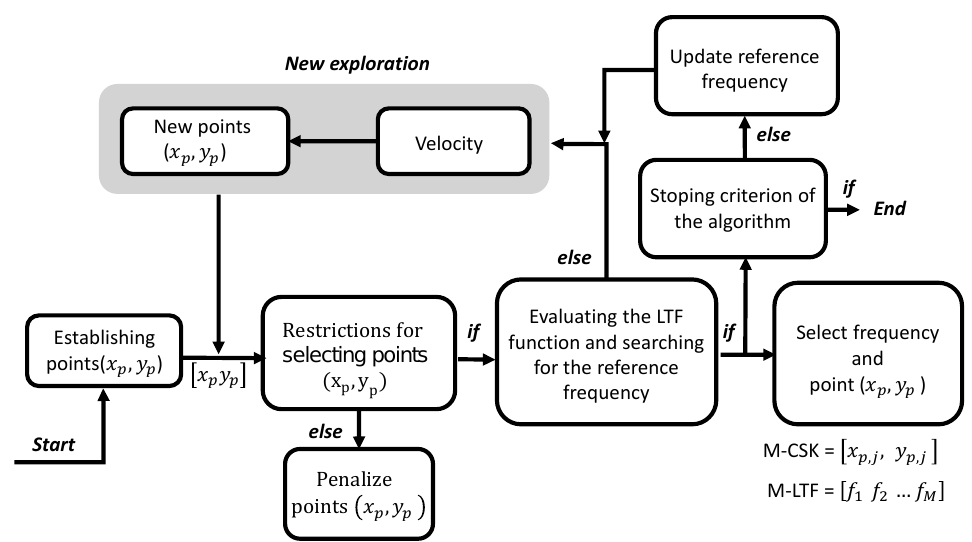
Figure 8. Proposed optimization algorithm to design M-CSK-LTF